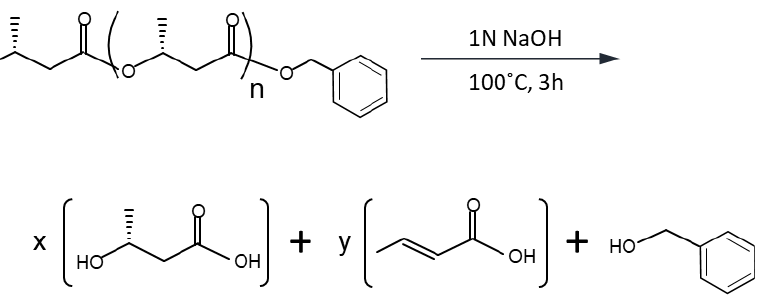
Figure 2. HPLC chromatograms recorded at 210 nm. ( a ) Crotonic acid; ( b ) 3-hydroxybutyrate; ( c ) benzyl alcohol; and ( d ) alkaline-treated P(3HB) with benzyl alcohol end. R. I. means relative intensity.